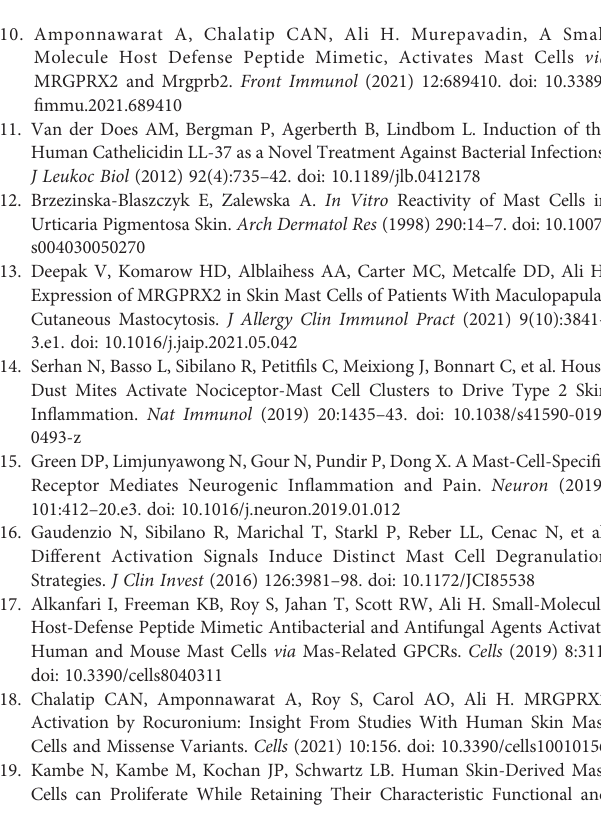
Supplementary Figure 1 | Cell Surface Expression of MRGPRX2 in Human Skin MCs from Three Donors. Skin MCs were incubated with PE-conjugated anti- MRGPRX2 antibody (blue histograms) or isotype control antibody (grey histograms) and receptor expression was assessed by fl ow cytometry N=3. Supplementary Figure 2 | SP Induces Degranulation in Mouse PMCs via MrgprB2. Peritoneal MCs from WT and MrgprB2 - / - mice were exposed to SP and b -hexosaminidase release was determined. Data presented are mean ± SEM of N=3 experiments. Statistical signi fi cance was determined by two-way ANOVA with Tukey ’ s multiple comparisons at a value ***p < 0.001. Supplementary Figure 3 | Flow Cytometry Gating Strategy of LAMP1 Expression in PMCs N=3. Supplementary Figure 4 | Flow cytometry gating strategy of peritoneal lavage immune cells. Numbers indicate the percentage of cells pre-gated on viability. Debris- cells, single cells, CD45 + live cells, CD45 + CD11b + Ly6G + live cells